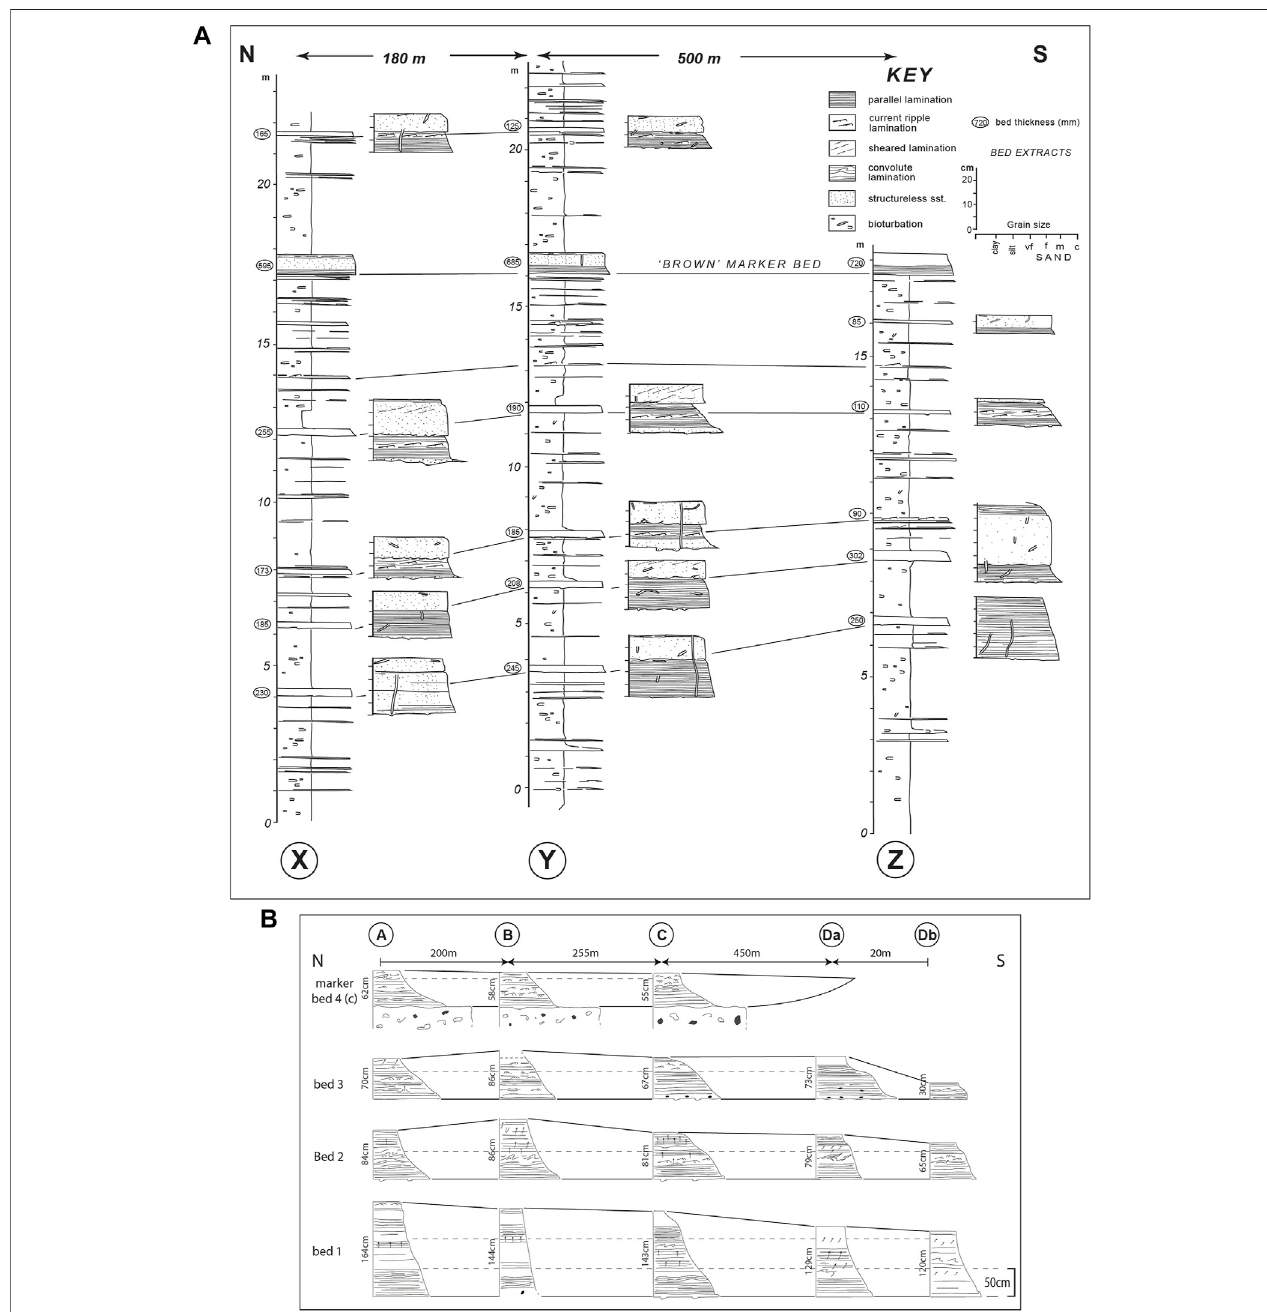
FIGURE 8 | Lateral correlation of Phase 3 sandy event beds fi lling the Alfaro sub-basin (A) N-S correlation of thin beds (stratigraphic location shown in Figure 5 ) over a distance of 680 m. More detailed log extracts illustrate the unusual character of the sandstones. See text for discussion (B) N-S correlation over a distance of 925 m of thicker event beds in the upper part the sub-basin fi ll showing thinning as the southern margin of the sub-basin is approached, and pinch-out of a bed with a carbonate provenance before those with a siliciclastic composition. Location of logged beds shown in Figures 4 , 5 .